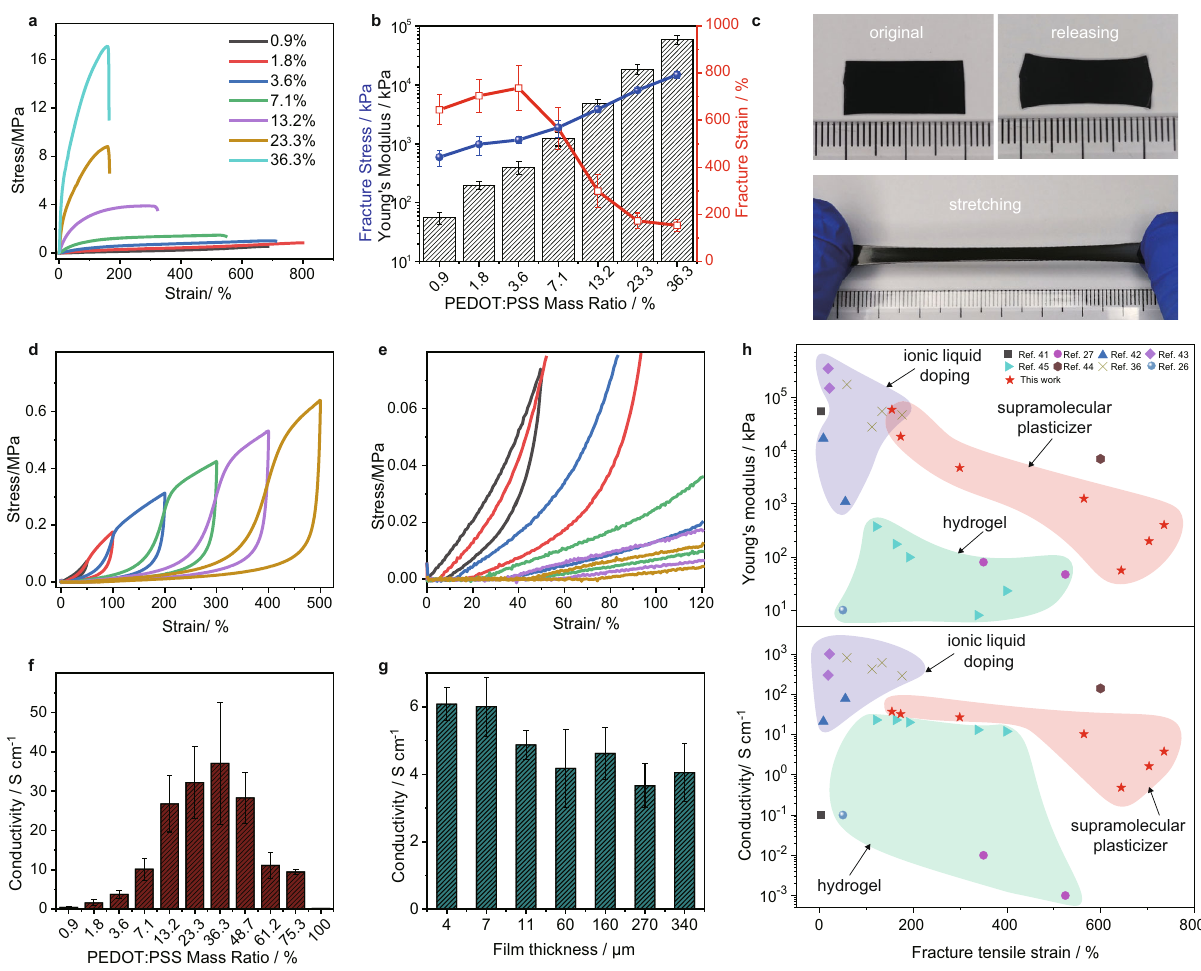
Fig. 2 Mechanical and electrical performance of SACP fi lms. a Stress-strain curves. b Young ’ s modulus, fracture stress, and fracture strain of the free-standing fi lms with different PEDOT:PSS loadings. c Images of the fi lms (with PEDOT:PSS mass ratio of 3.6%) presenting little residual strain even after being stretched to 400% of strain. d Stress-strain curves of the fi lms (with PEDOT:PSS mass ratio of 3.6%) under cyclic loading-unloading tests. e Magnifying stress-strain curves between 0 – 120% for checking residual strain after stretching. f Conductivity of the fi lms with different PEDOT:PSS loadings. g Conductivity of the fi lms (with PEDOT:PSS mass ratio of 3.6%) with different thicknesses. h Relationships of Young ’ s modulus and conductivity versus fracture strain of a variety of PEDOT:PSS composites reported in references and this work. The error bars show the standard deviations from at least three